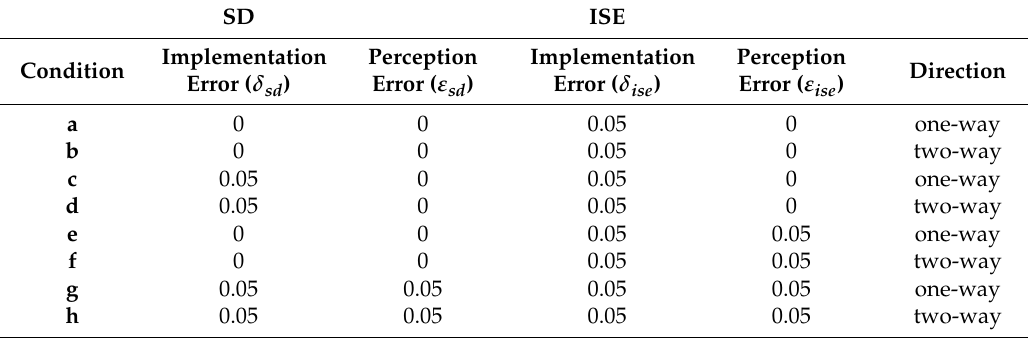
Table 3. Error conditions in Inaba, Takahashi, and Ohtsuki [48] and in the current study. SD